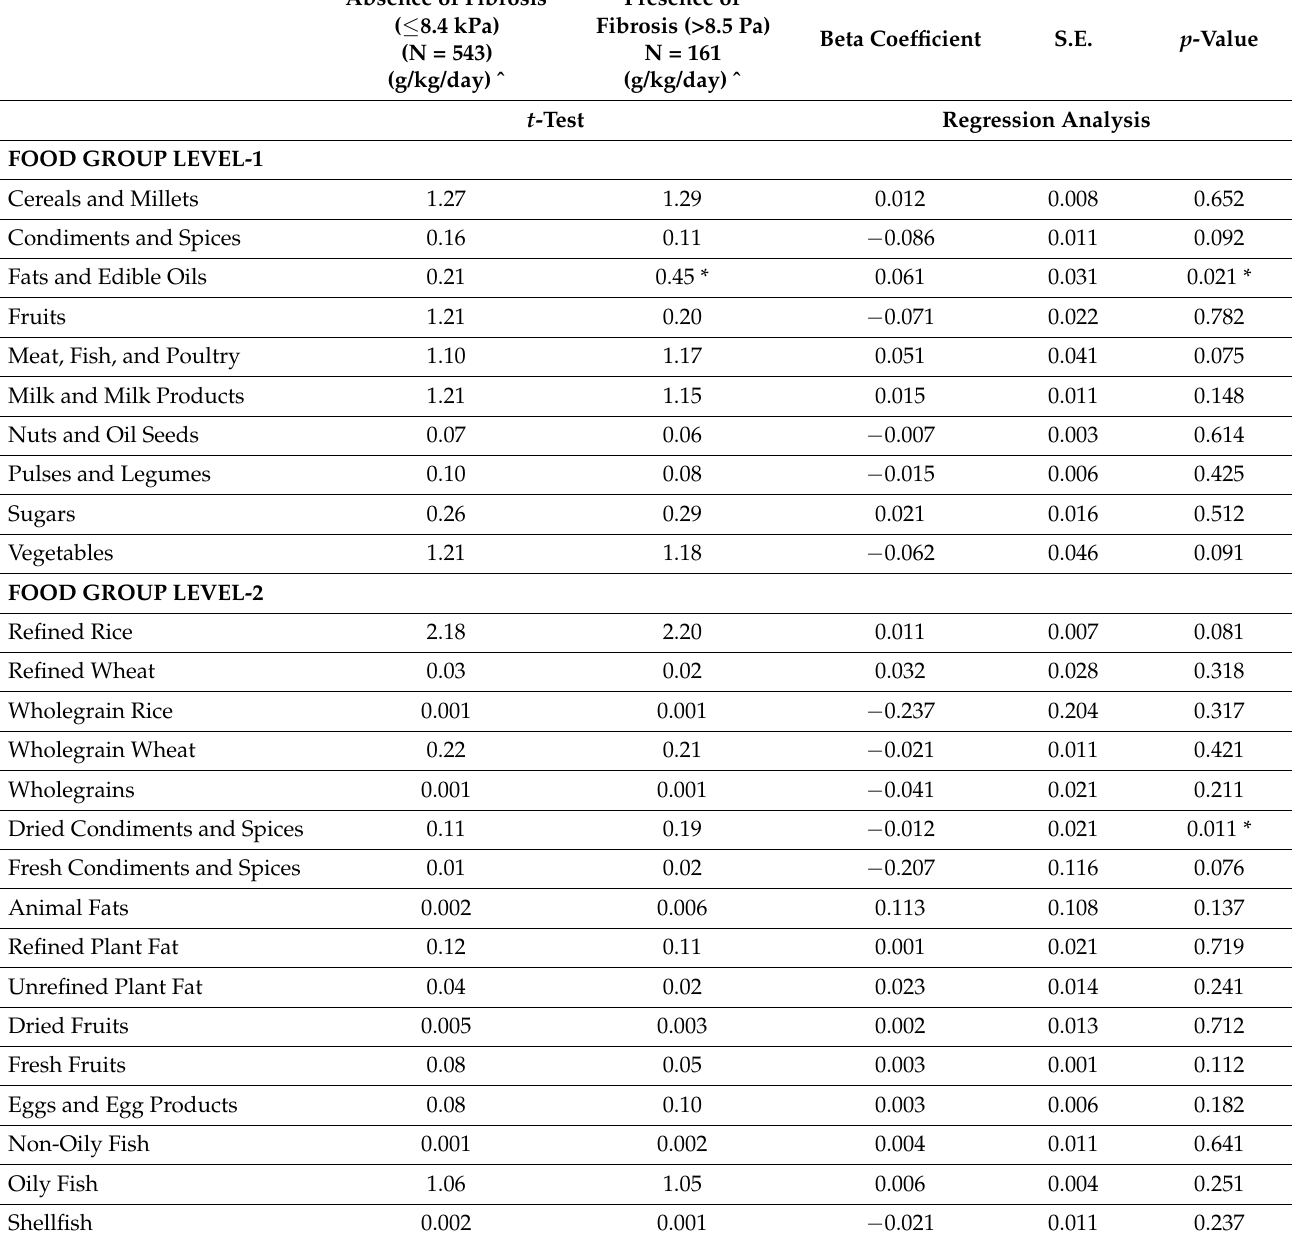
Table 3. Comparison of mean intakes of individual food groups and their associations with degree of fibrosis based on liver stiffness